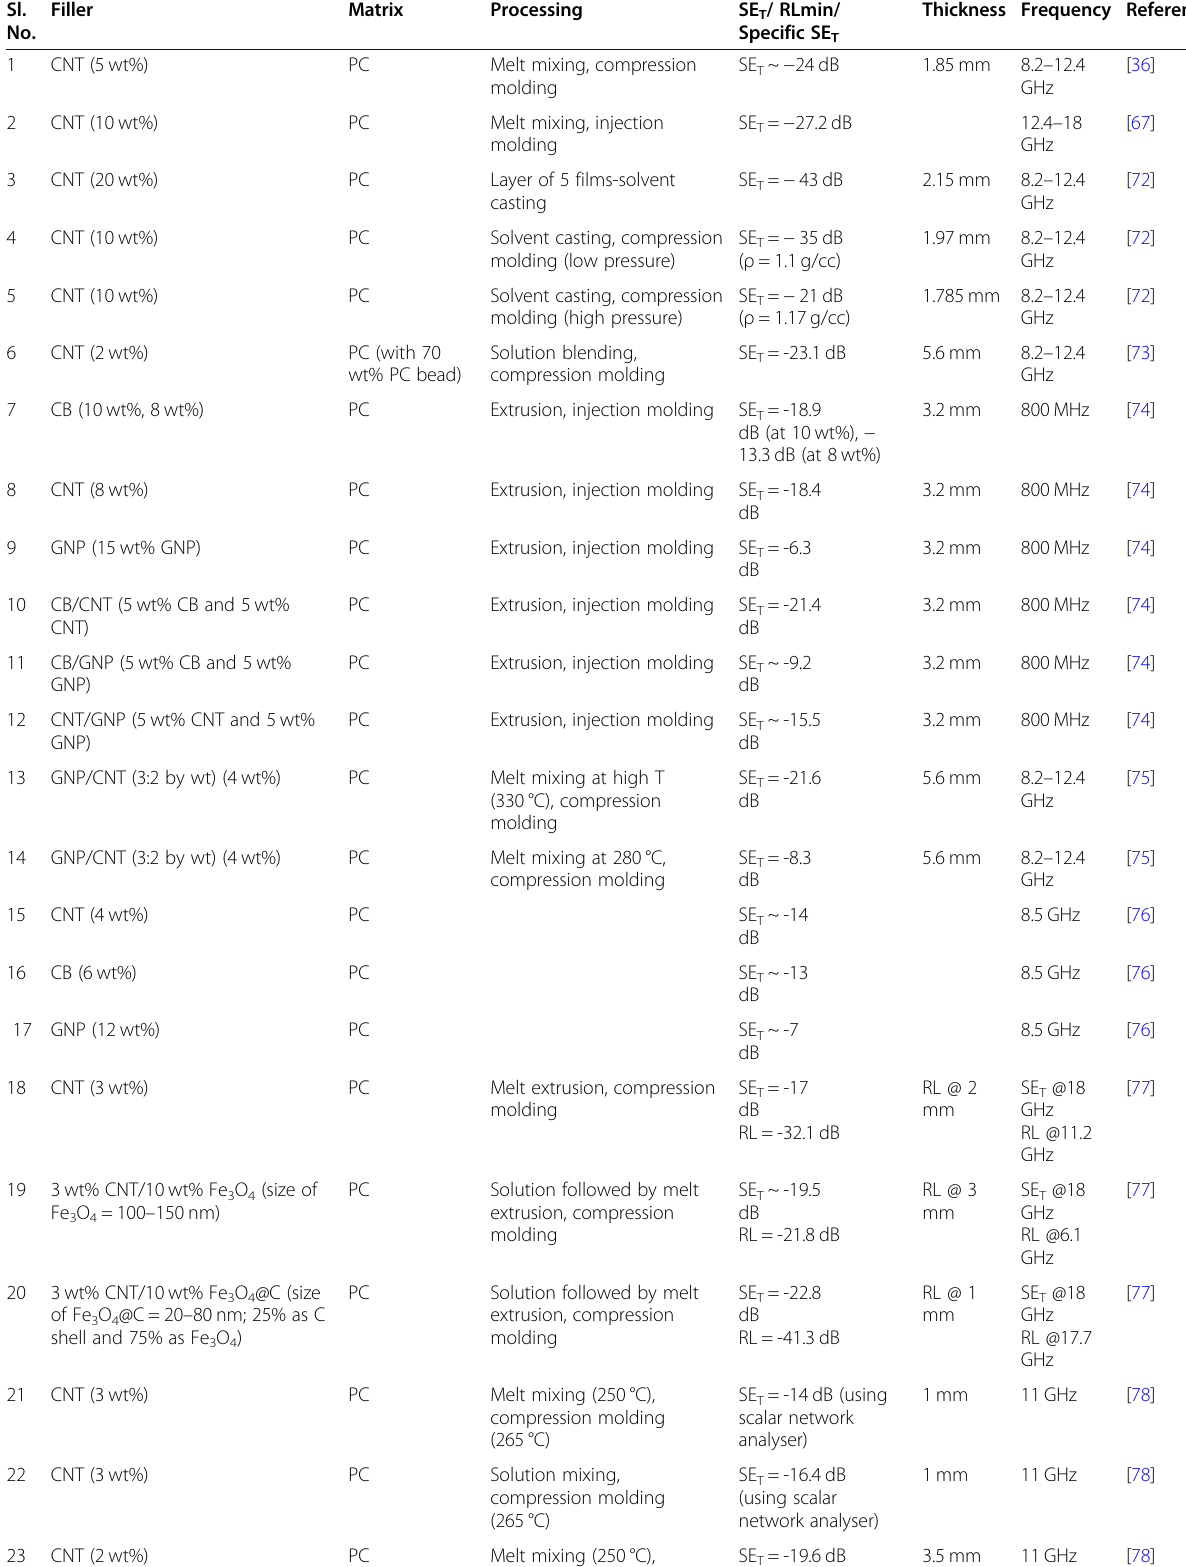
Table 4 List of PC-based hybrid structure for EMI shielding applications Sl. No.